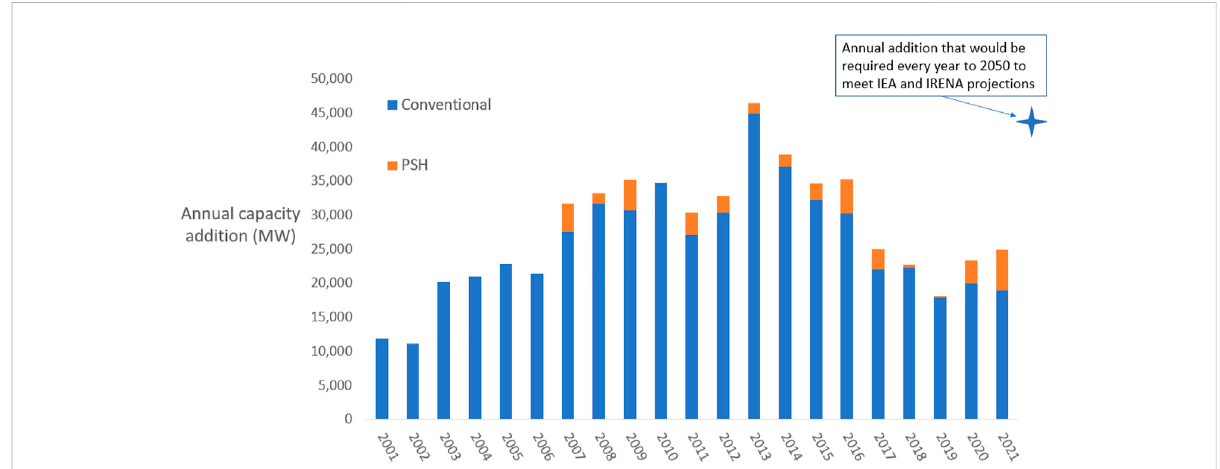
FIGURE 1 Annual global capacity additions for conventional hydropower (blue) and pumped storage hydropower (orange) for the past two decades (data from IRENA, 2022). Note that PSH data were not available before 2007. The blue star in the upper right indicates the level of annual addition that would need to be reached, and then sustained for 30 years, to achieve the forecasts from IEA (2021) and IRENA (2021) for 2050.